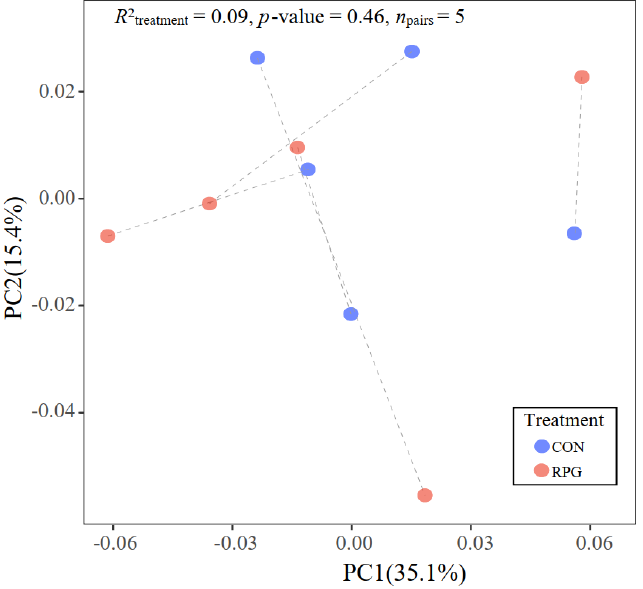
Figure 2. Principal coordinate analysis based on the Bray–Curtis dissimilarity matrix of liver protein profiles. Paired cows are connected with dashed lines.